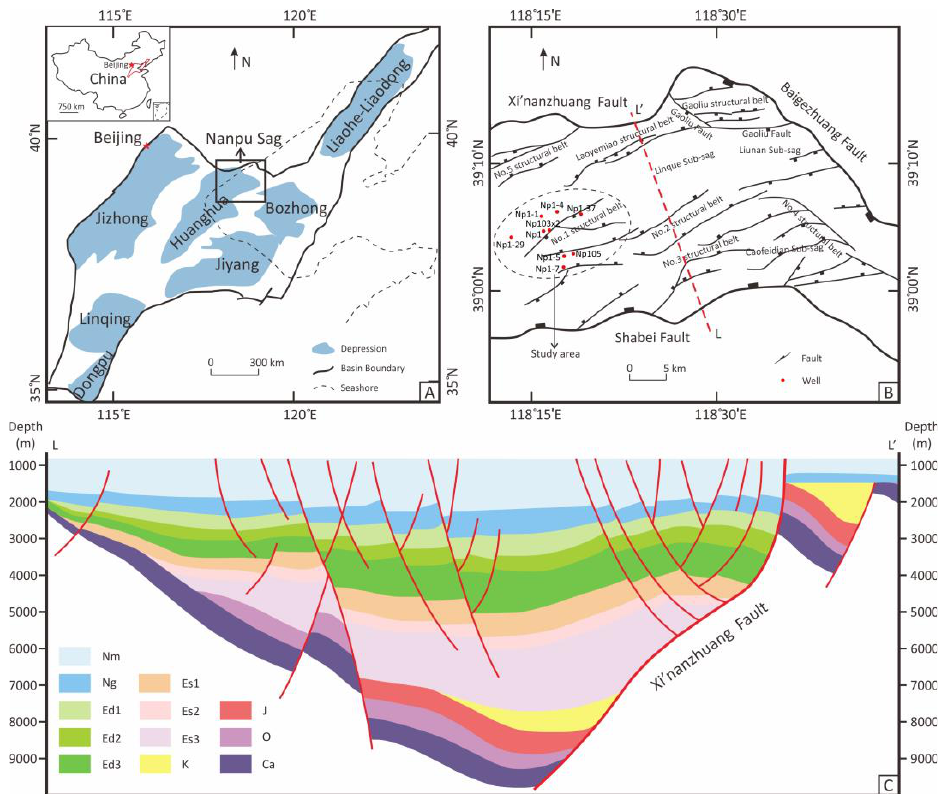
Figure 1. ( A ) Regional and location map of Nanpu Sag in Bohai Bay Basin [18,30]; ( B ) Tectonic setting of Nanpu Sag, and sampling wells are marked by red dots with well names attached next to them [18,25]; ( C ) Schematic geological cross-section representative of the structural setting of Nanpu Sag [38].